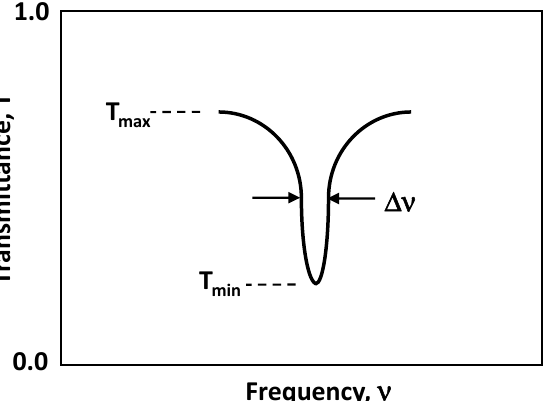
Figure 3. Characteristic of the THz absorption signatures evaluated in this work.